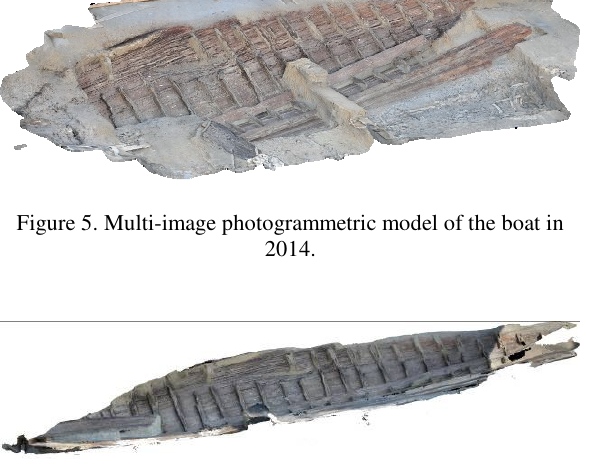
Figure 6. Multi-image photogrammetric model of the boat in 2015.